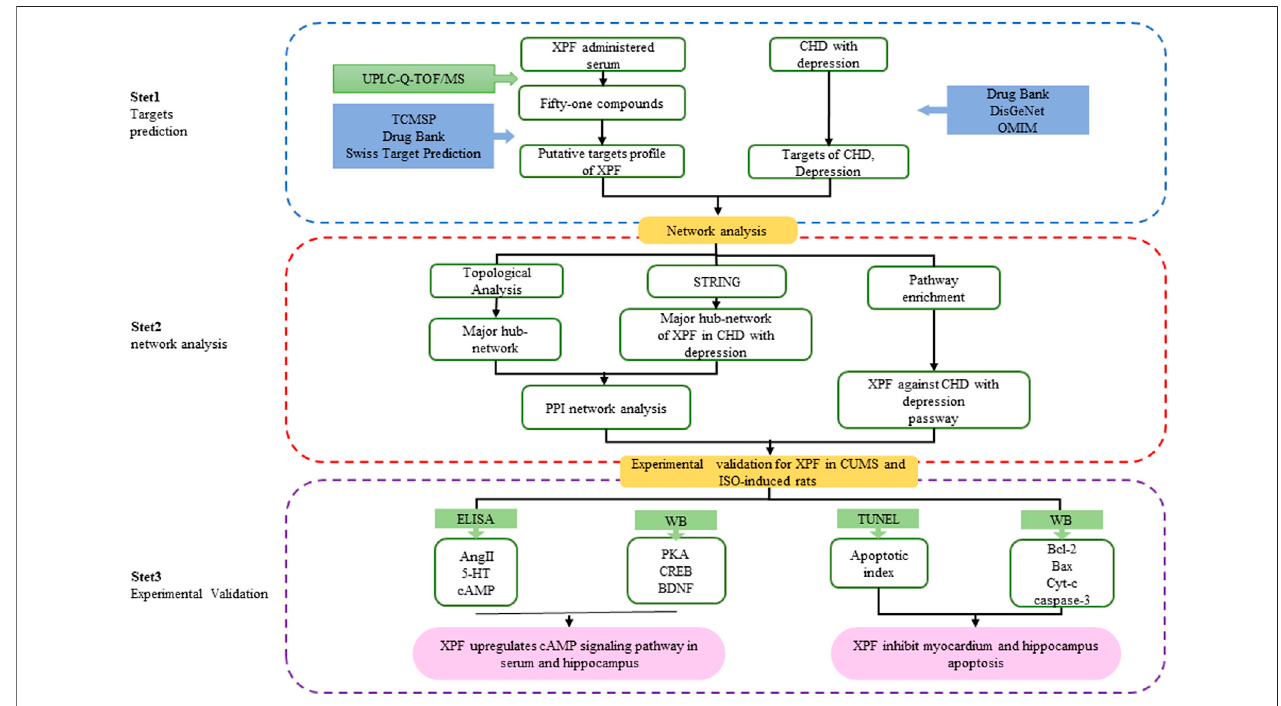
FIGURE 1 | Flowchart of the